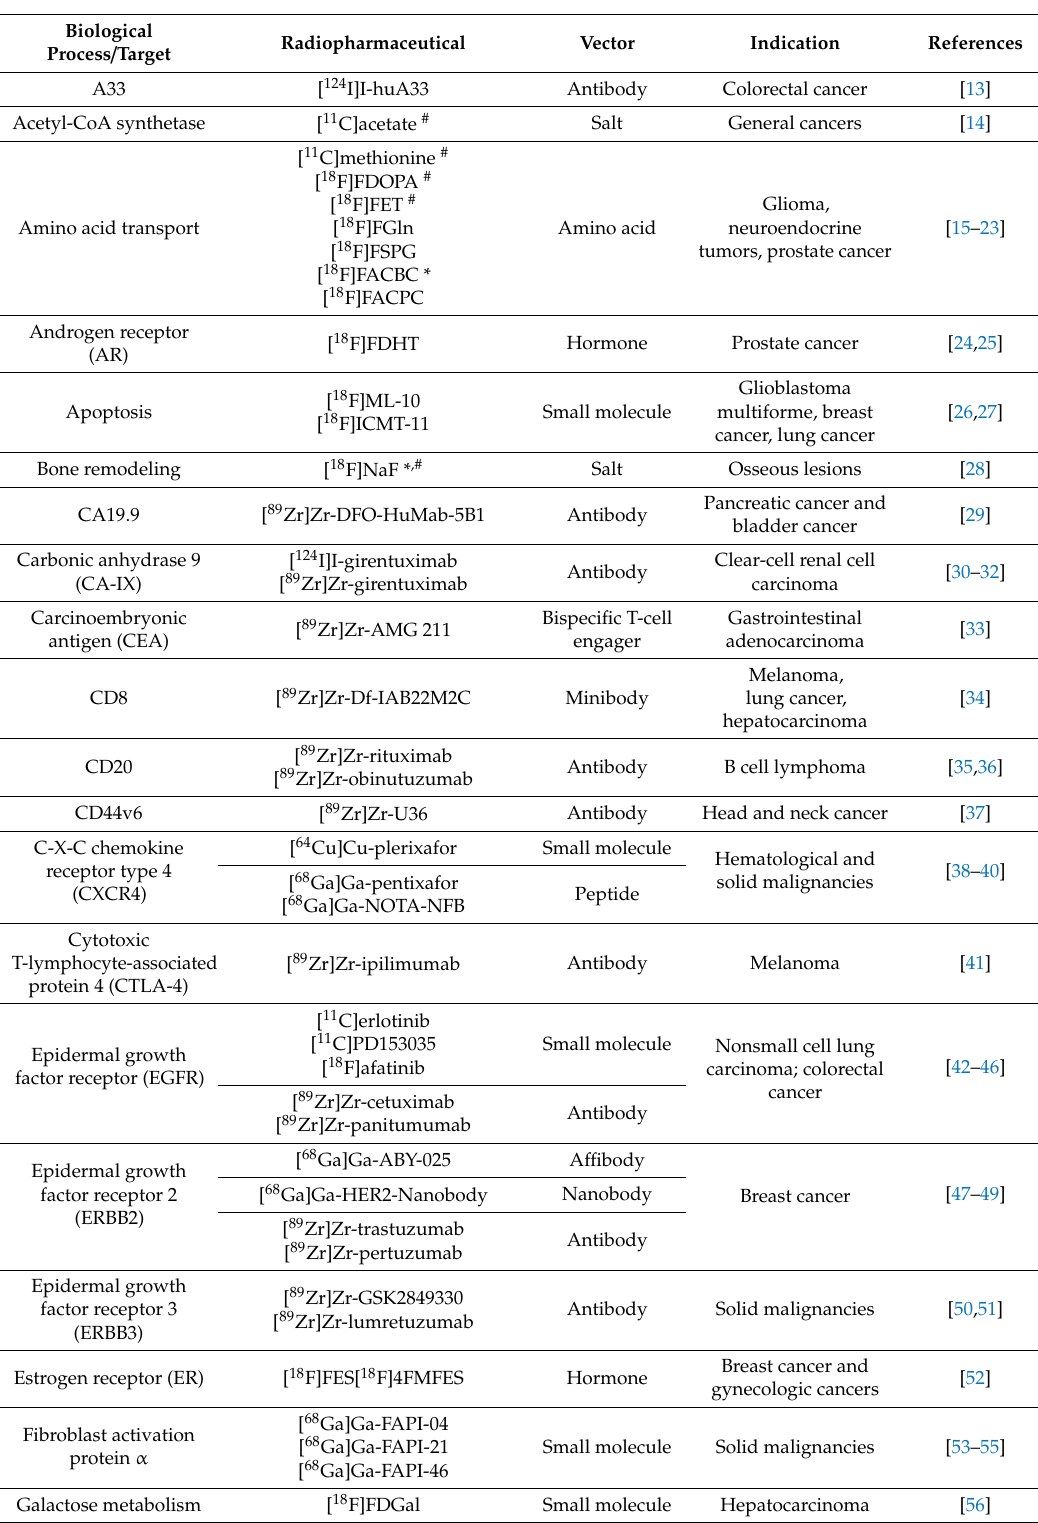
Table 1. Representative positron emission tomography (PET) radiopharmaceuticals evaluated in clinical studies for